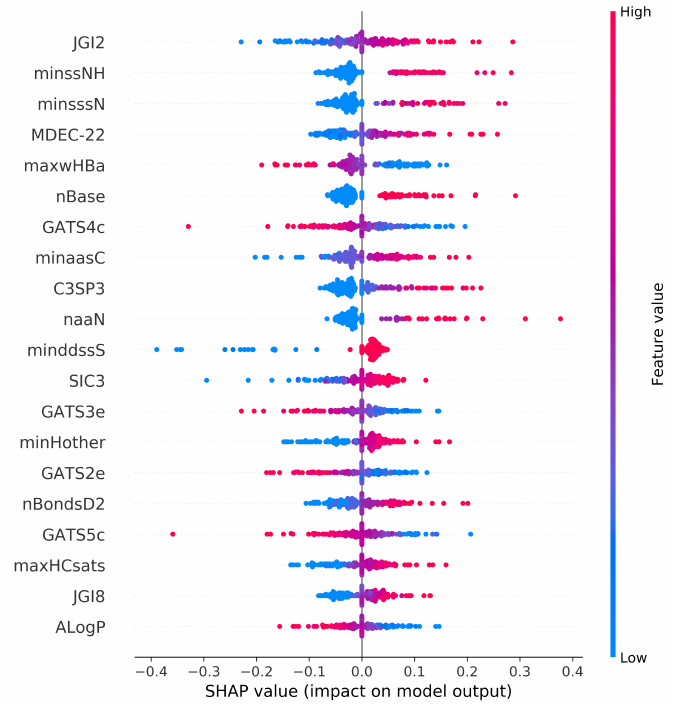
Figure 7. SHAP summary plot. Visualization of the Shapley values and molecular descriptor values in the SVM model. Each point is associated with a Shapley value for a single compound and descriptor. The color of the points is determined by their descriptor values, while the horizontal axis displays the Shapley values calculated. The vertical axis depicts both the descriptors and their distribution, arranged by their mean absolute Shapley values. The model’s most important descriptor is at the very top of the